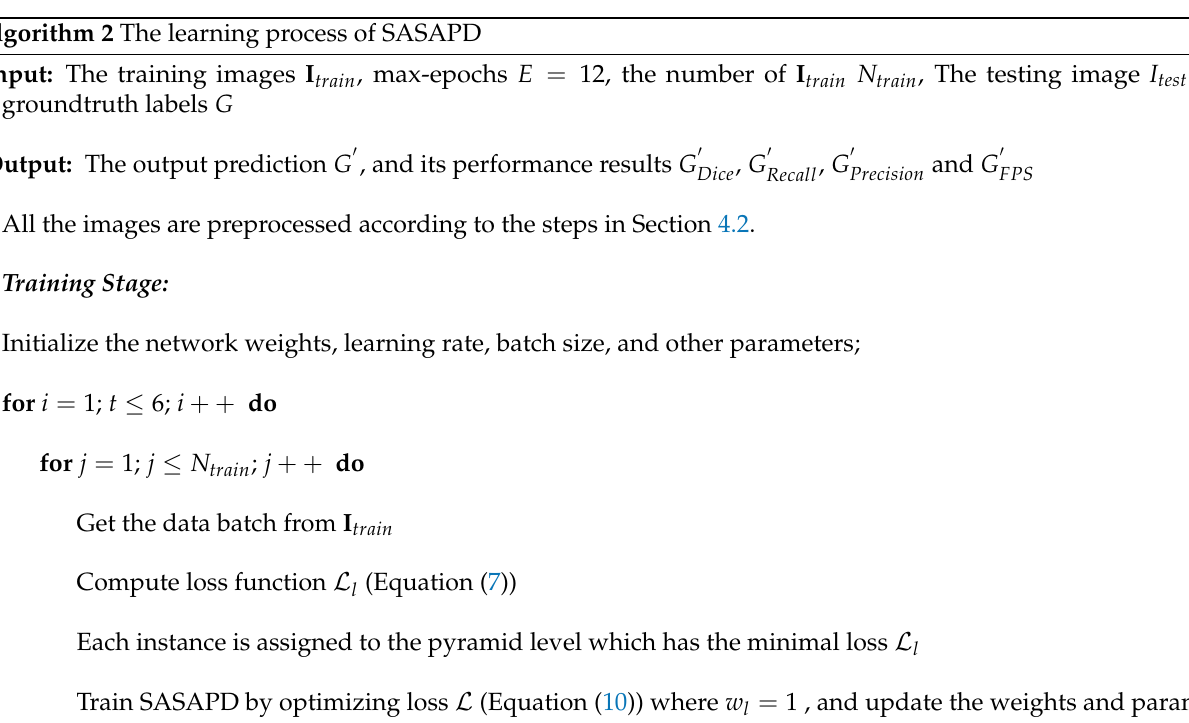
Algorithm 2 The learning process of